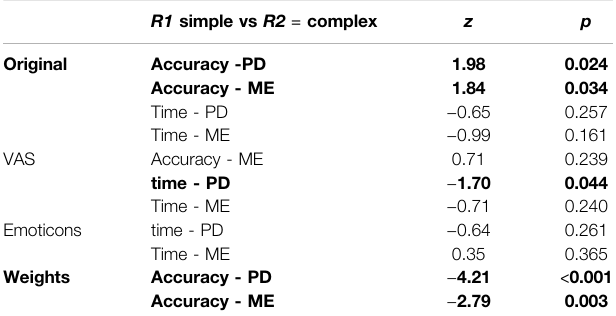
TABLE 7 | Comparisons of Correlations between the Simple and Complex Problem Solving